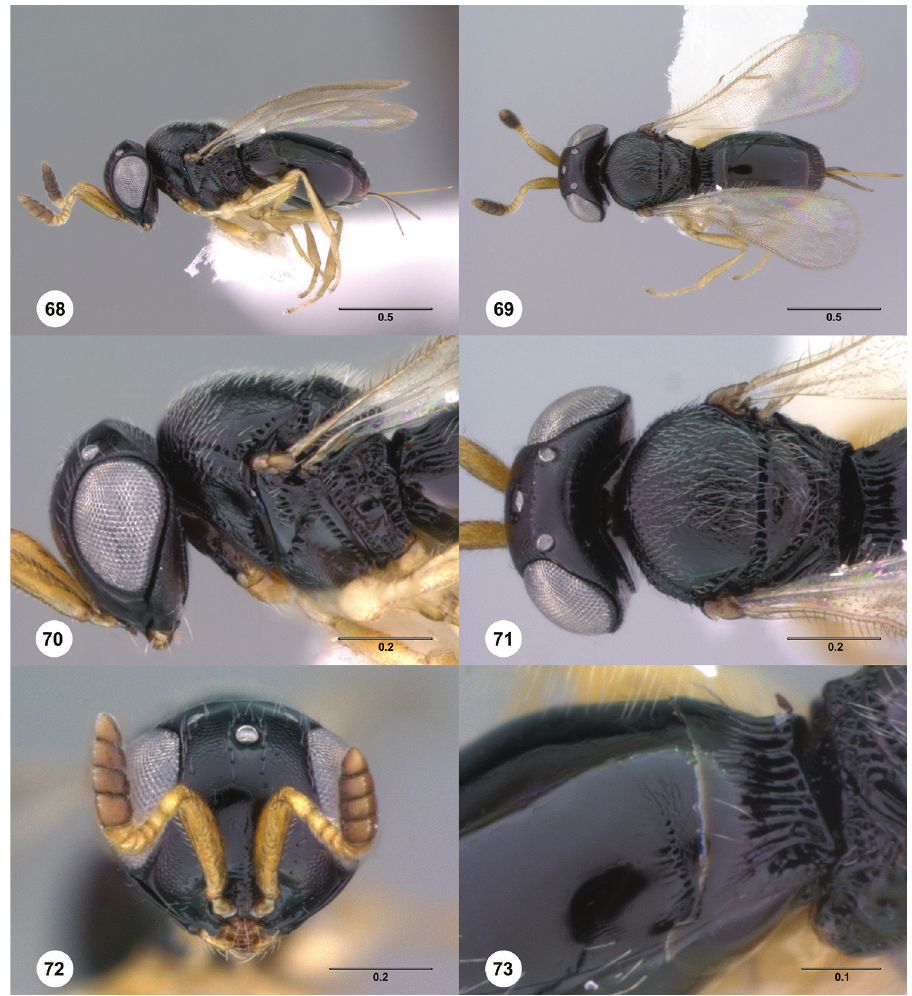
70 Head, mesosoma, lateral view 71 Head, mesosoma, dorsal view 72 Head, mouthparts, anteroventral view 73 T1–T2, lateral view. Scale bar in millimeters.